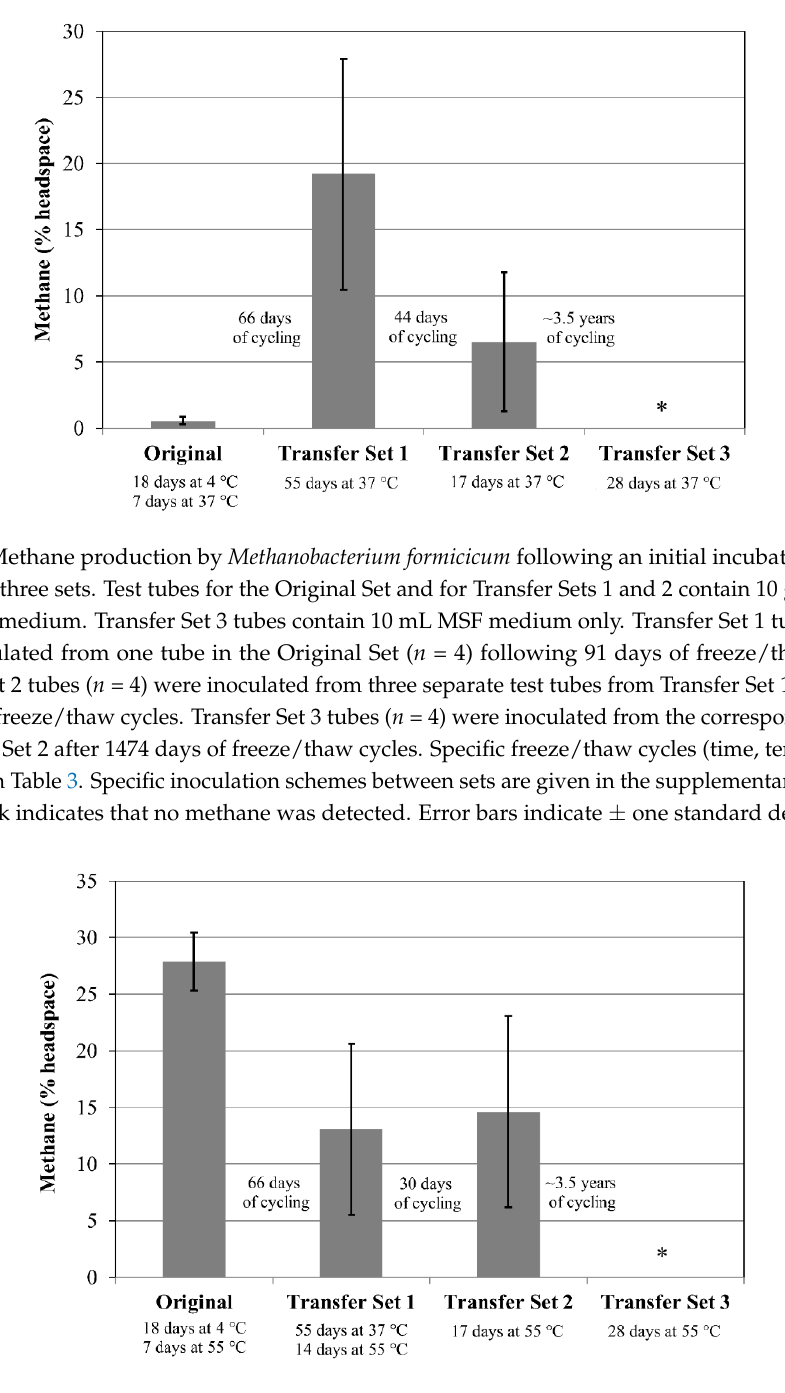
Figure 5. Methane production by Methanothermobacter wolfeii following an initial incubation period for each of three sets. Test tubes for the Original Set and for Transfer Sets 1 and 2 contain 10 g sand and 5 mL MM medium. Transfer Set 3 tubes contain 10 mL MM medium only. Transfer Set 1 tubes ( n = 3) were inoculated from two separate test tubes in the Original Set ( n = 3) following 91 days of freeze/thaw cycles. Transfer Set 2 tubes ( n = 5) were inoculated from two separate test tubes from Transfer Set 1 following 99 days of freeze/thaw cycles. Transfer Set 3 tubes ( n = 5) were inoculated from the corresponding tube in Transfer Set 2 after 1474 days of freeze/thaw cycles. Specific freeze/thaw cycles (time, temperature) are given in Table 4. Specific inoculation schemes between sets are given in the supplementary material. The asterisk indicates that no methane was detected. Error bars indicate ± one standard deviation.